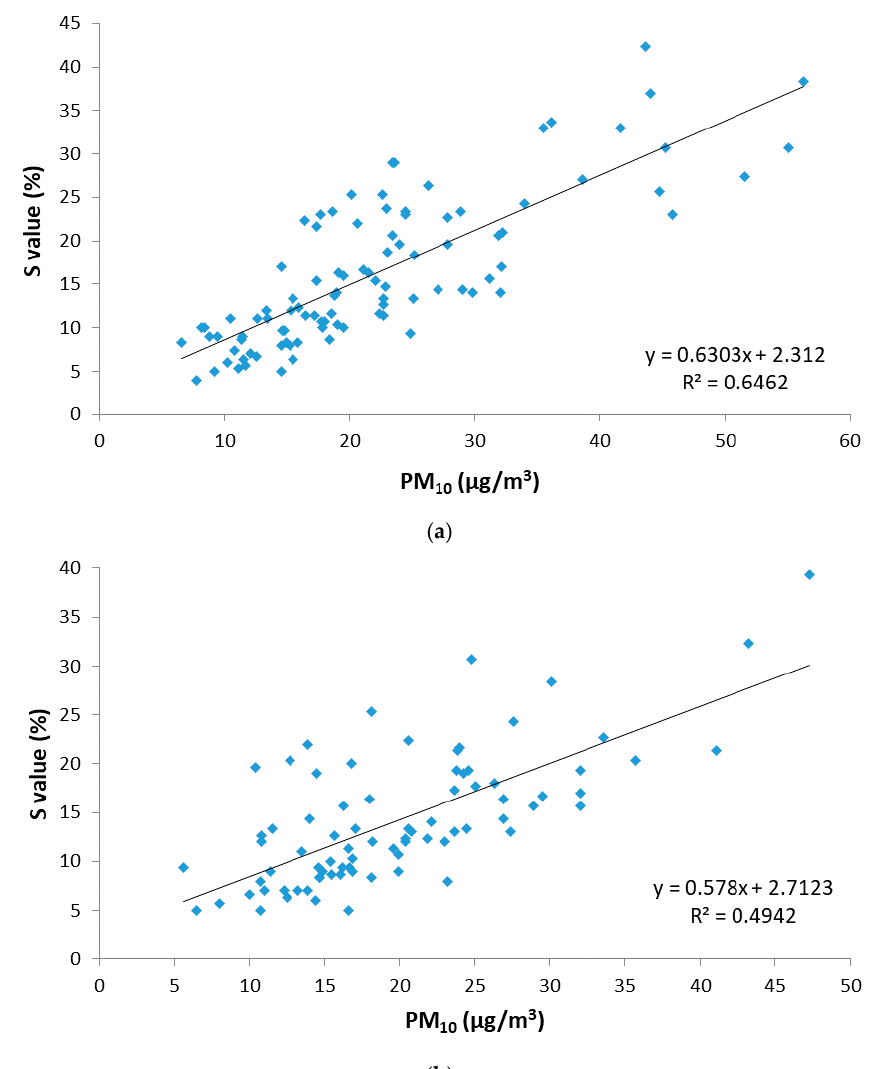
Figure 8. Relationship between saturation (S HSV ) and gravimetric PM 10 concentration for days under remote source influence (SDO days) during 2015. ( a ) At Badajoz location; ( b ) at Monfragüe location.